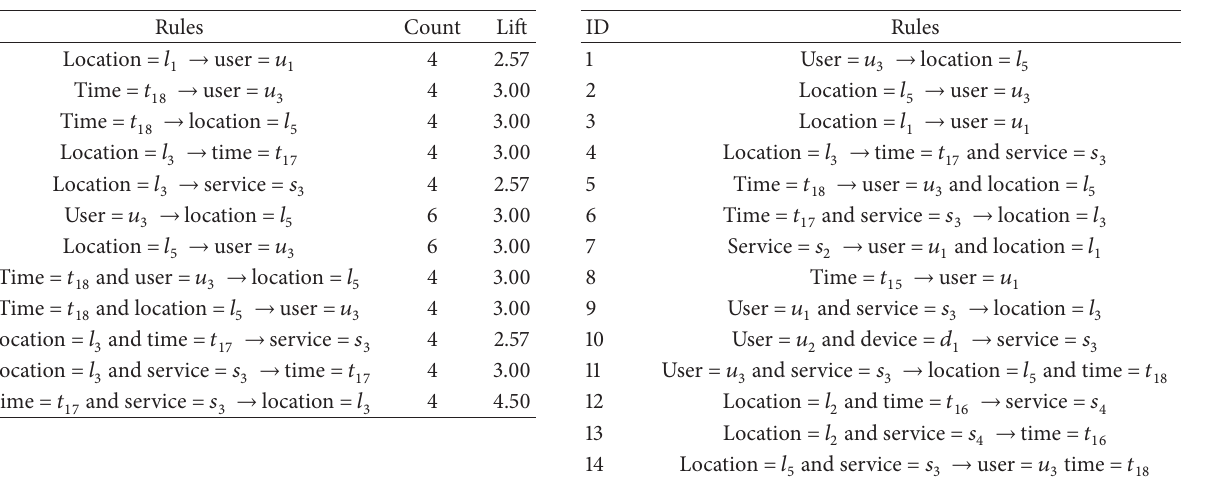
Table 7: The results based on Apriori algorithm.